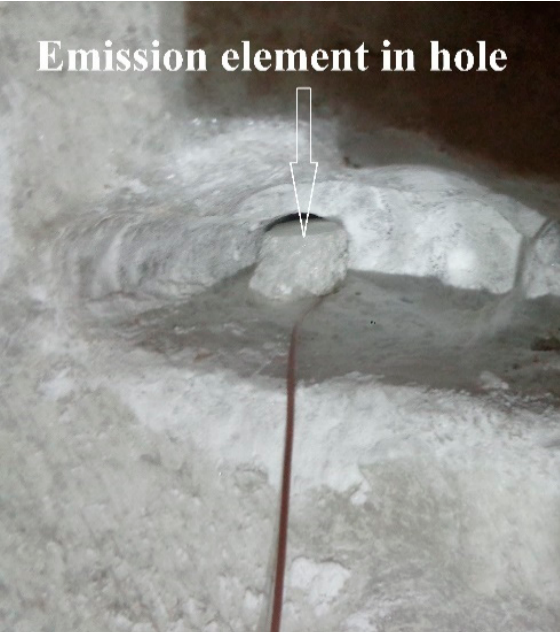
Figure 8. The emission element introduced in saline environment for vertical plane.